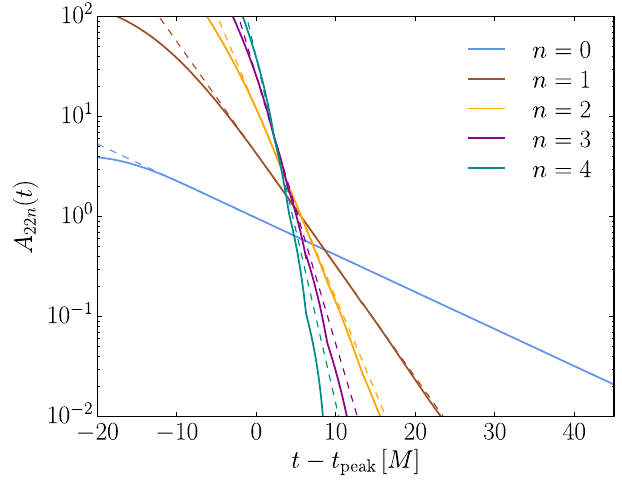
FIG. 9. The numerically recovered amplitudes for the funda- mental QNM and the first few overtones at each fit time, t (solid curves). Dashed lines are the same as the lines in Fig. 8. The numerically extracted amplitudes across t agree very well with the expected decay for the longest-lived modes, while modes that decay more quickly are more susceptible to fitting issues. Interestingly, the fundamental mode is in excellent agreement with the expected decay rate at times preceding the peak amplitude of the